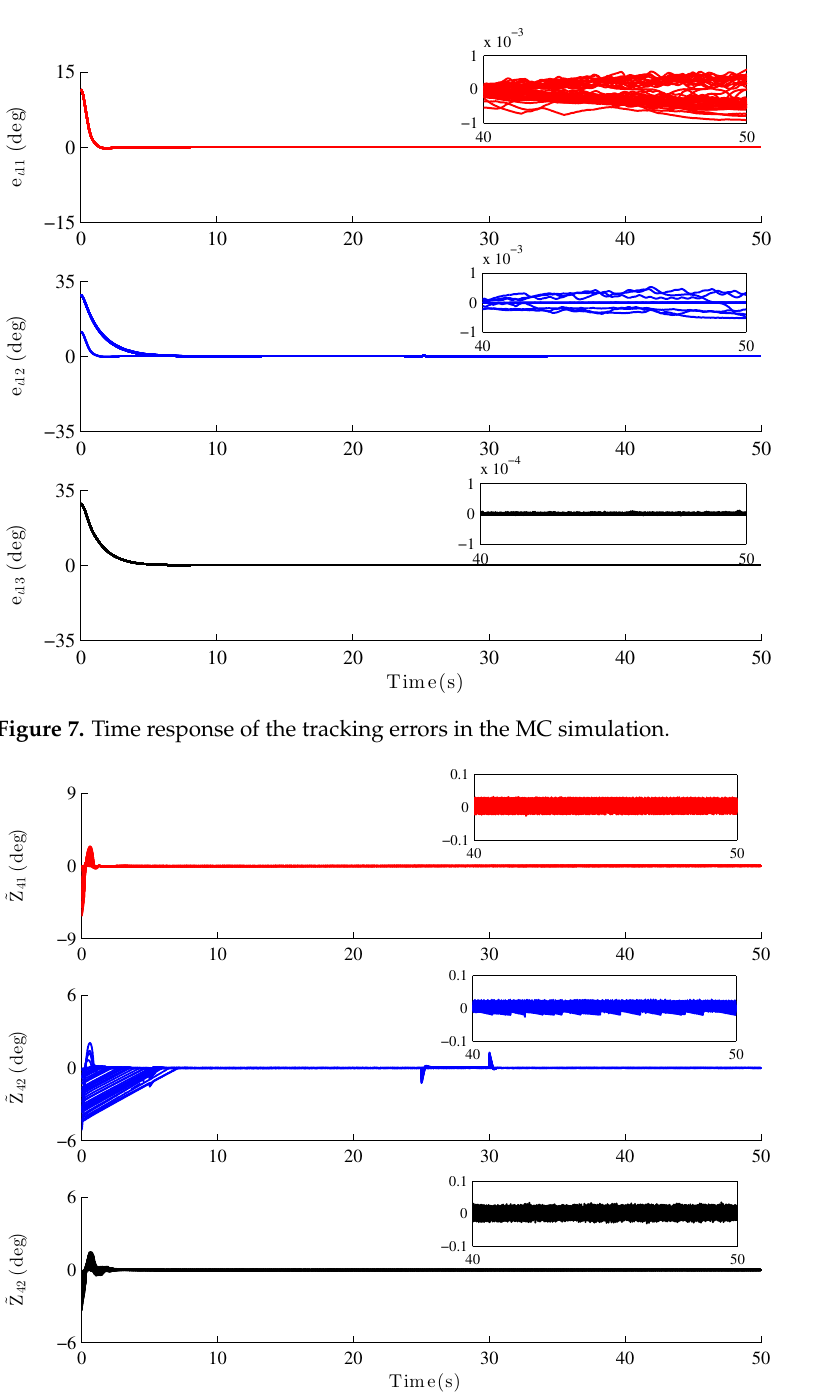
Figure 8. Time response of the observation errors in the MC